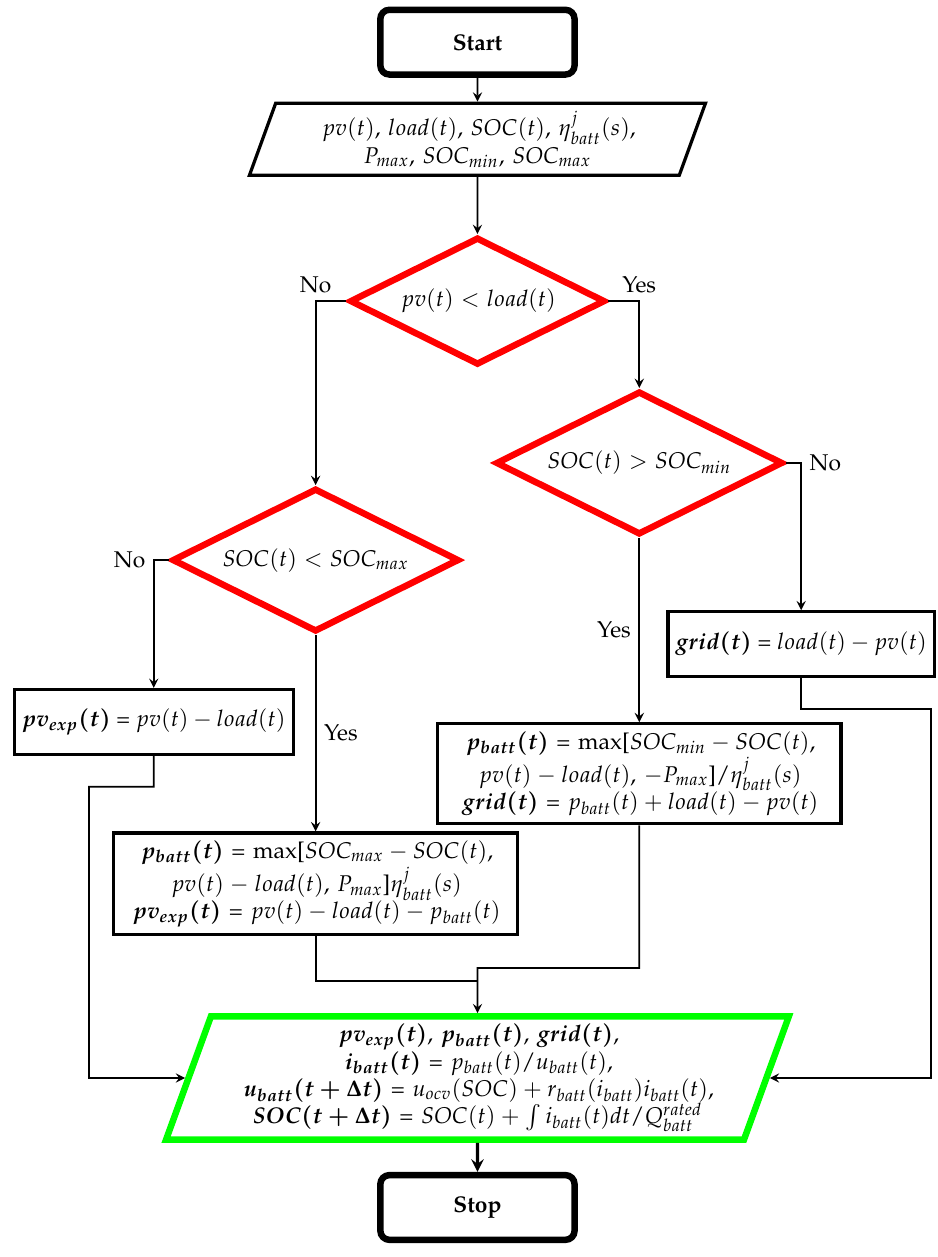
Figure 6. Flow chart of battery charge and discharge control.